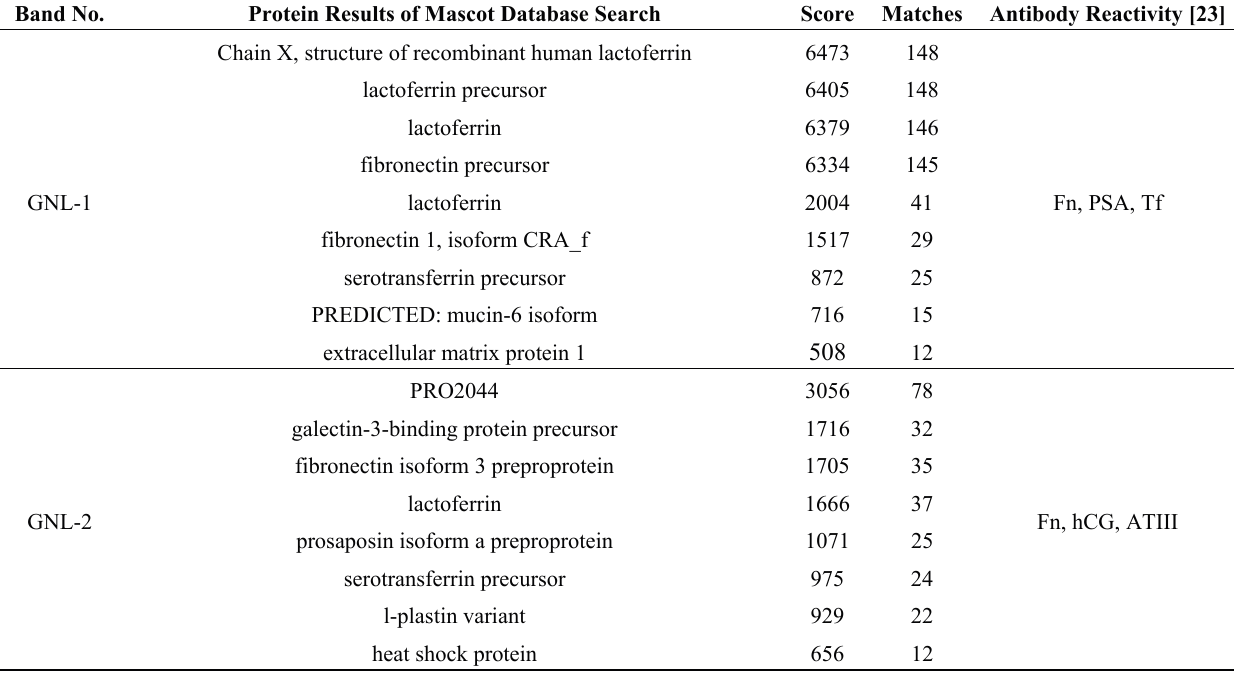
Table 1. Mass spectrometry identification of glycoproteins isolated from SDS-PAGE gels. Band No. Protein Results of Mascot Database Search Score Matches Antibody Reactivity [23]